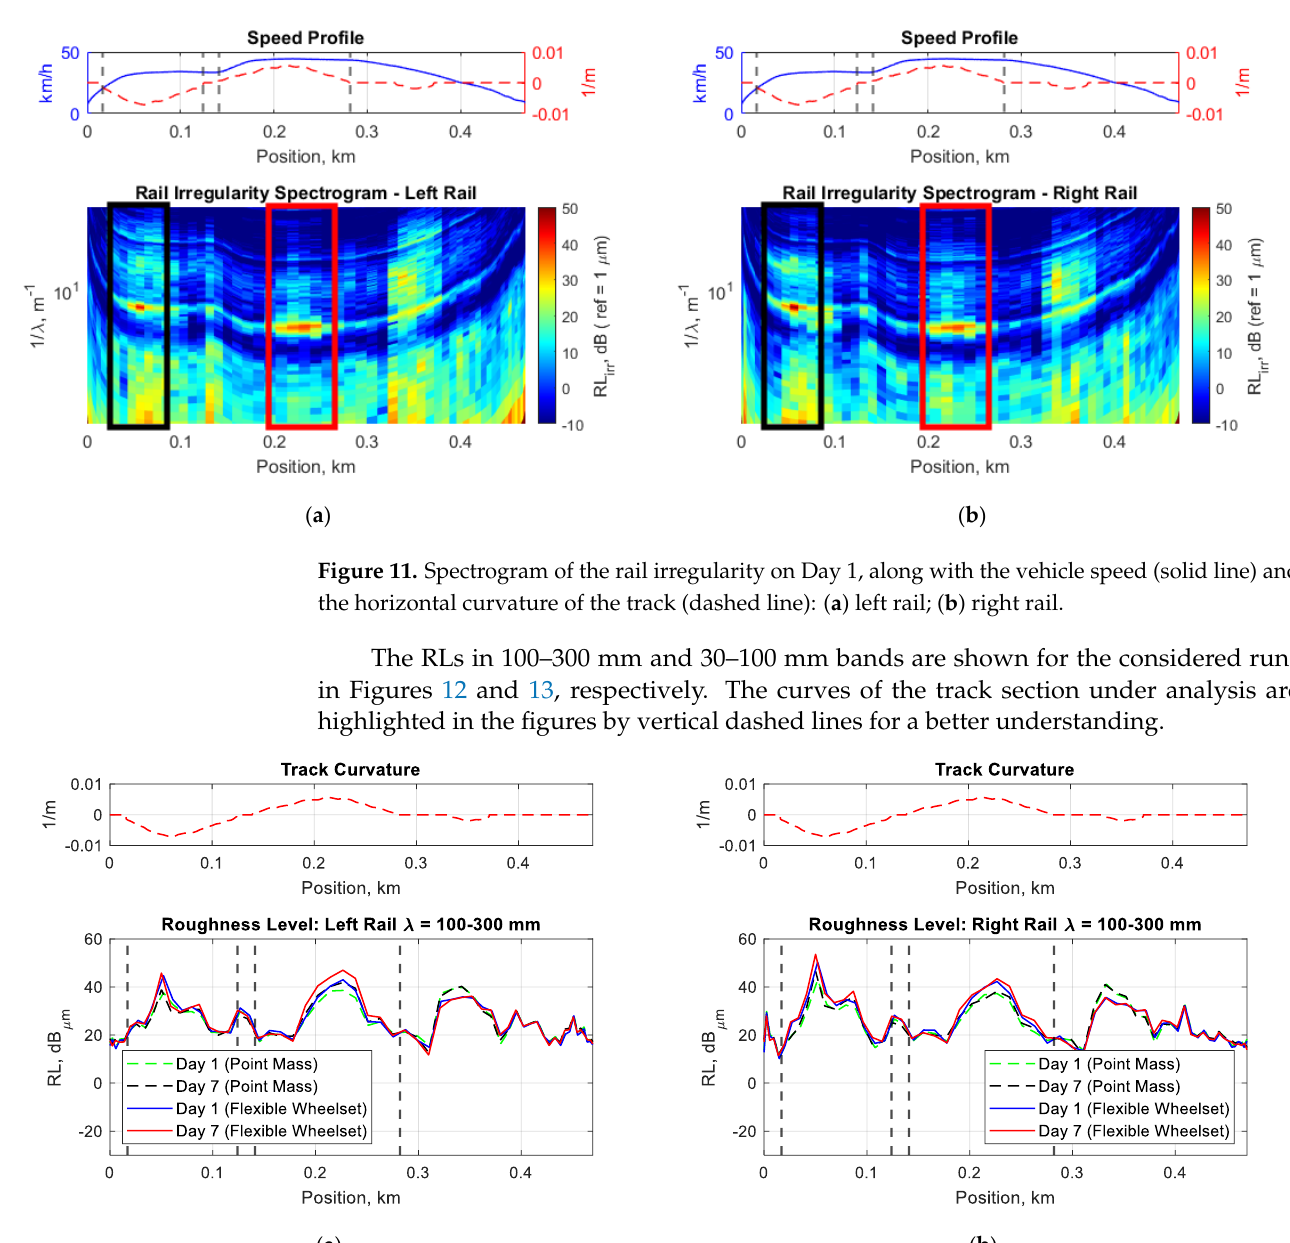
Figure 13. Roughness Level in the 30–100 mm wavelength band: ( a ) left rail; ( b ) right rail. By looking at the RL in the 100–300 mm wavelength band, the highest RL values are observed on the low rail of the curves (Figure 12b for the second curve). This is in accord- ance with the spectrograms of Figure 11: they indicate a corrugation wavelength of 130 mm on the first curve and a 170 mm corrugation wavelength on the second one. The av- erage speed on the first right curve is about 33 km/h, while the second one is negotiated at an average speed of 43 km/h (Figure 10). Thus, for both the curves, the frequency of excitation by the rail irregularity is about 70 Hz according to Equation (3), which corre- sponds to the natural frequency of the first bending mode of the wheelset. On account of the differences in the transfer functions reported in Figure 9 at the same frequency, the RL on the low rail estimated with the flexible wheelset model is 7 dB higher than the one predicted with the point mass model. The same difference is observed both on Day 1 and Day 7. This indicates that the transfer function calculated with the flexible wheelset model is more sensible for finding the presence of rail corrugation and therefore the proposed approach will be more effective for its monitoring. The RL on the high rail is lower with respect to the low rail, but its absolute value is in any case significant. As mentioned before, this is related to the fact that the two axle- boxes of the wheelset are not dynamically decoupled, and thus both axlebox